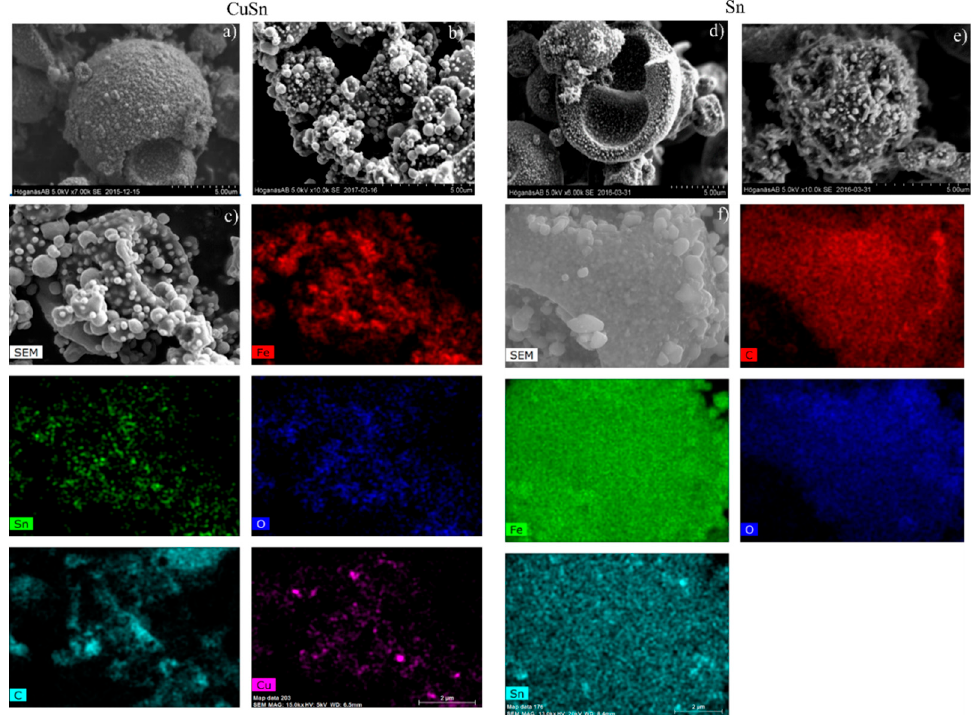
Figure 2. SEM and elemental mapping for samples of CuSn ( a – c ) and Sn ( d – f ).